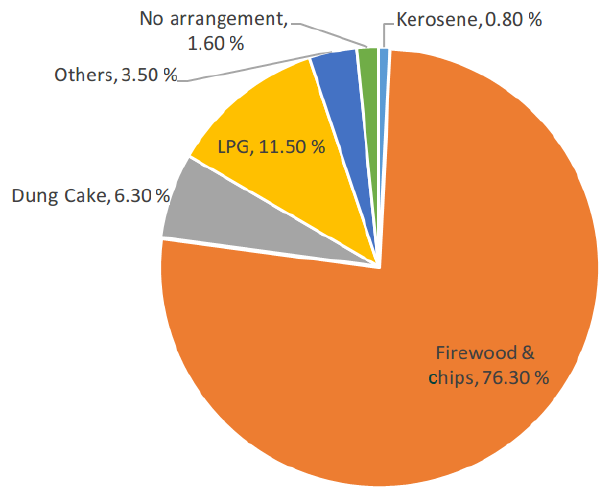
Figure 6. Energy sources used for cooking in rural India, 2009–